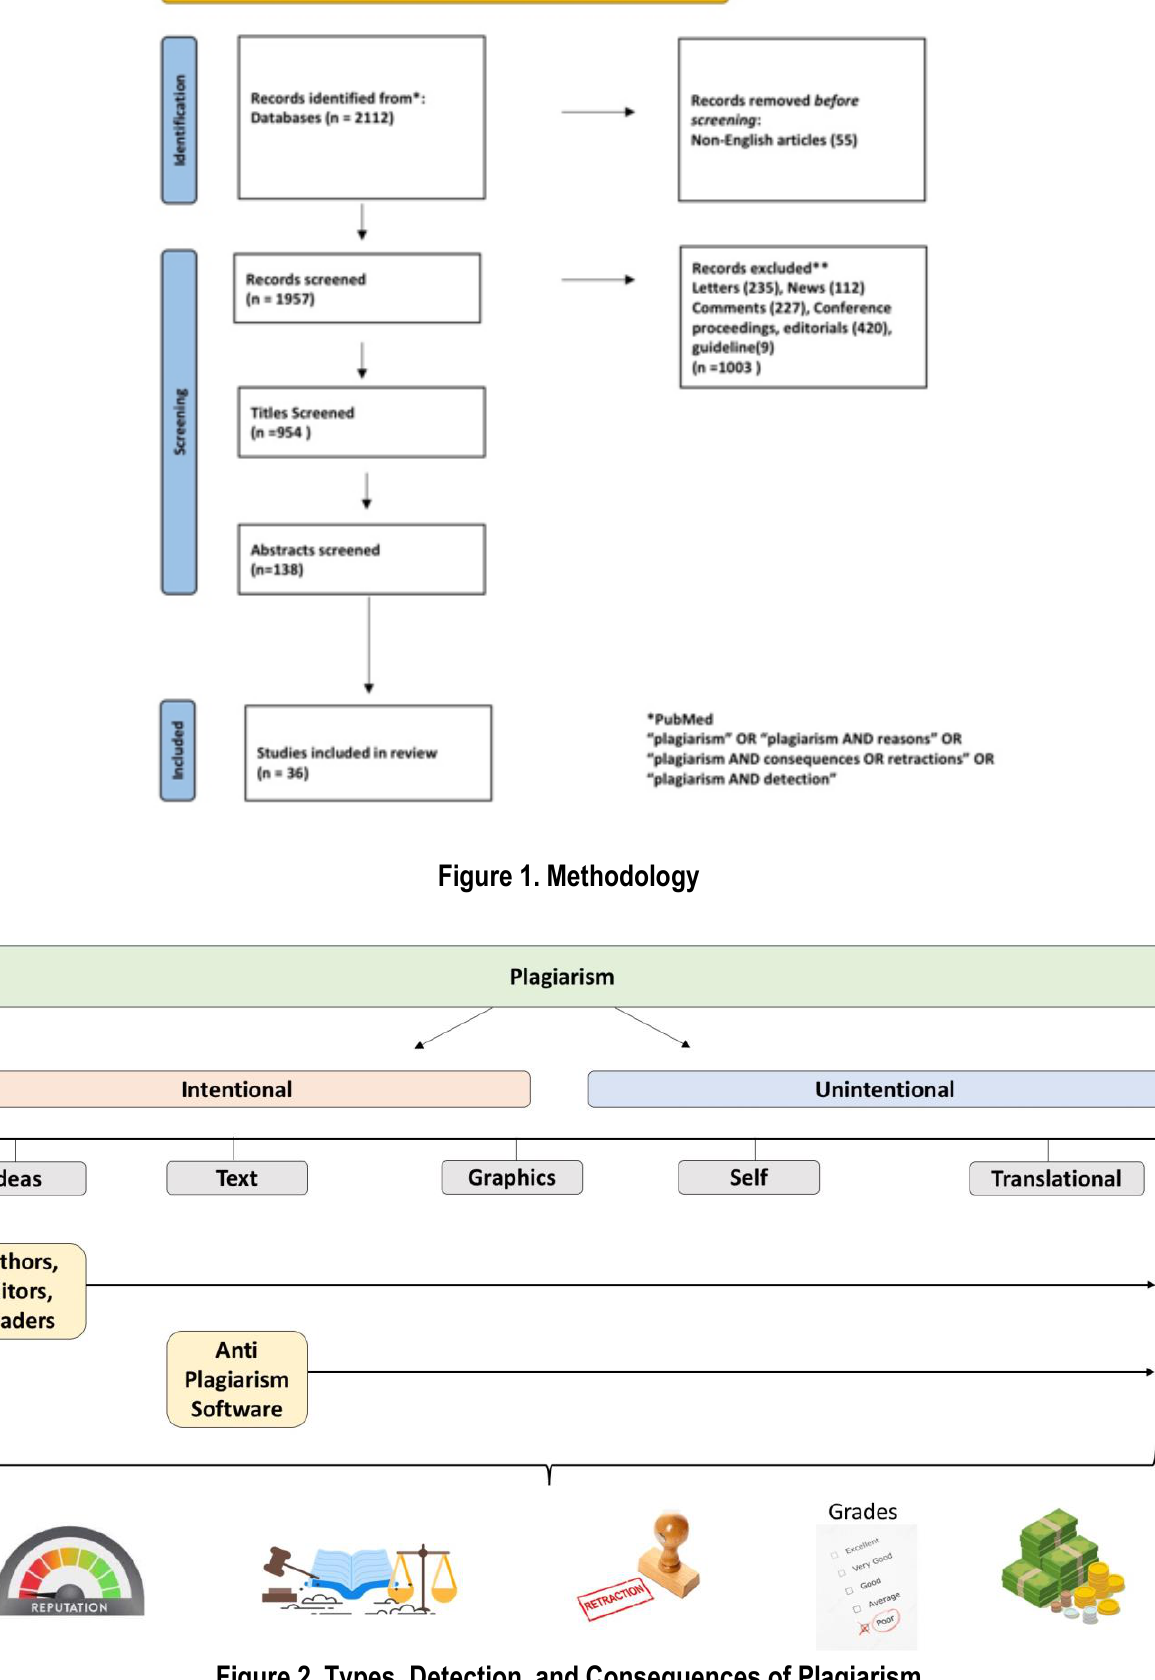
Figure 2. Types, Detection, and Consequences of